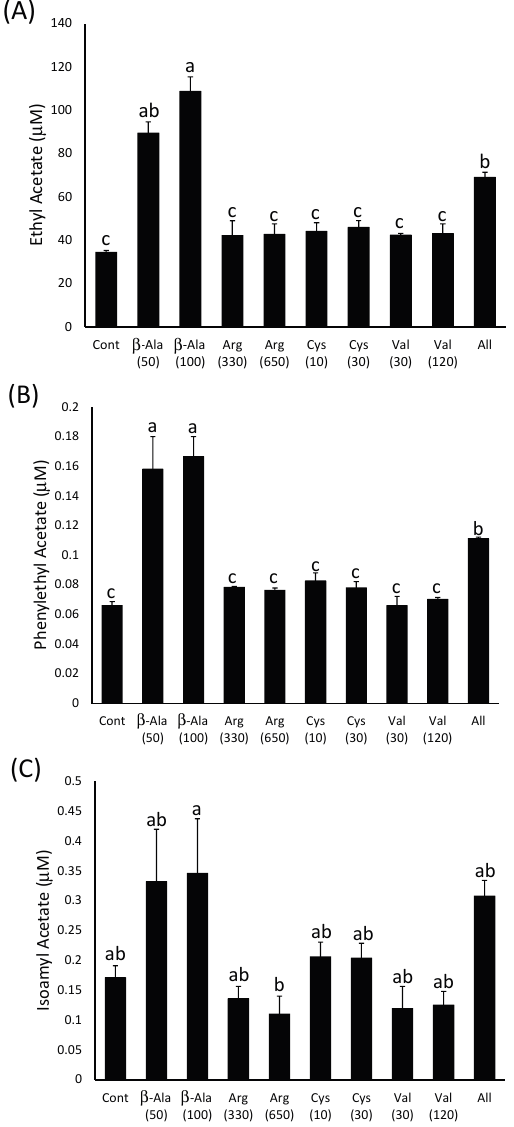
Figure 6. The concentration of ( A ) ethyl acetate, ( B ) isoamyl acetate and ( C ) phenylethyl acetate in model wines produced after the addition of amino acids as indicated on the x-axis. The number in brackets represents the concentration added in mg·L − 1 . Histograms represent the mean values (n = 3) and error bars show standard errors. Different letters (e.g., a, b, c) denote significant differences between treatments at p < 0.05 using ANOVA followed by Tukey’s post hoc